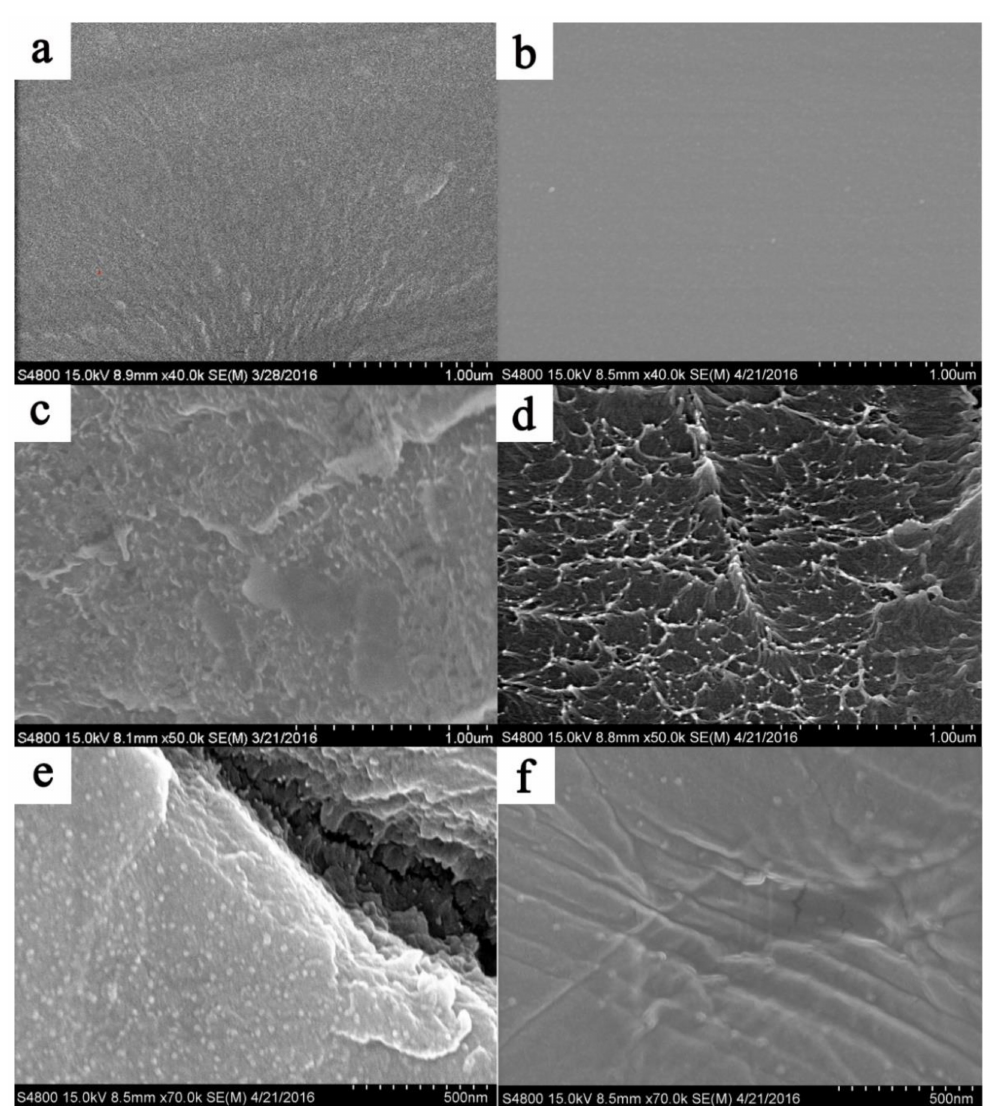
Figure 8. SEM micrographs of SPI membranes: ( a ) surface and ( b ) cross-section images of pristine SPI-ODA membrane; ( c ) surface and ( d ) cross-section images of pristine SPI-HFBAPP membrane; surface images of ( e ) SPI-ODA and ( f ) SPI-HFBAPP after cell